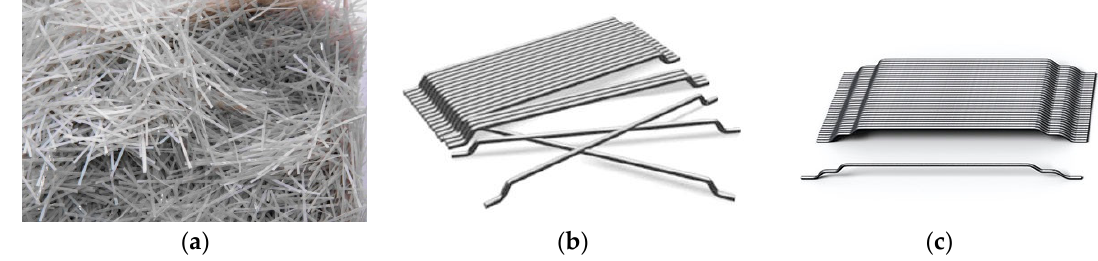
Figure 3. Fibers used in the investigation. ( a ) Strux(90 / 40) Synthetic, ( b ) 3D Steel Fiber, ( c ) 5D Steel Fiber.